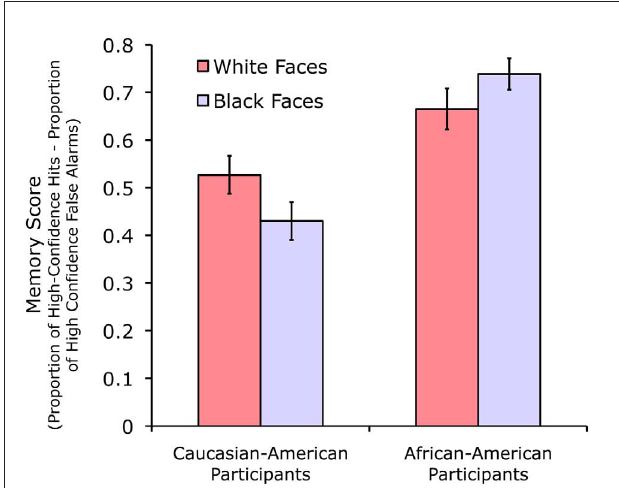
FiGuRE 2 | Recognition memory data demonstrating the other-race effect. Both Caucasian–American and African–American groups showed superior recognition memory for same-race faces compared to other-race